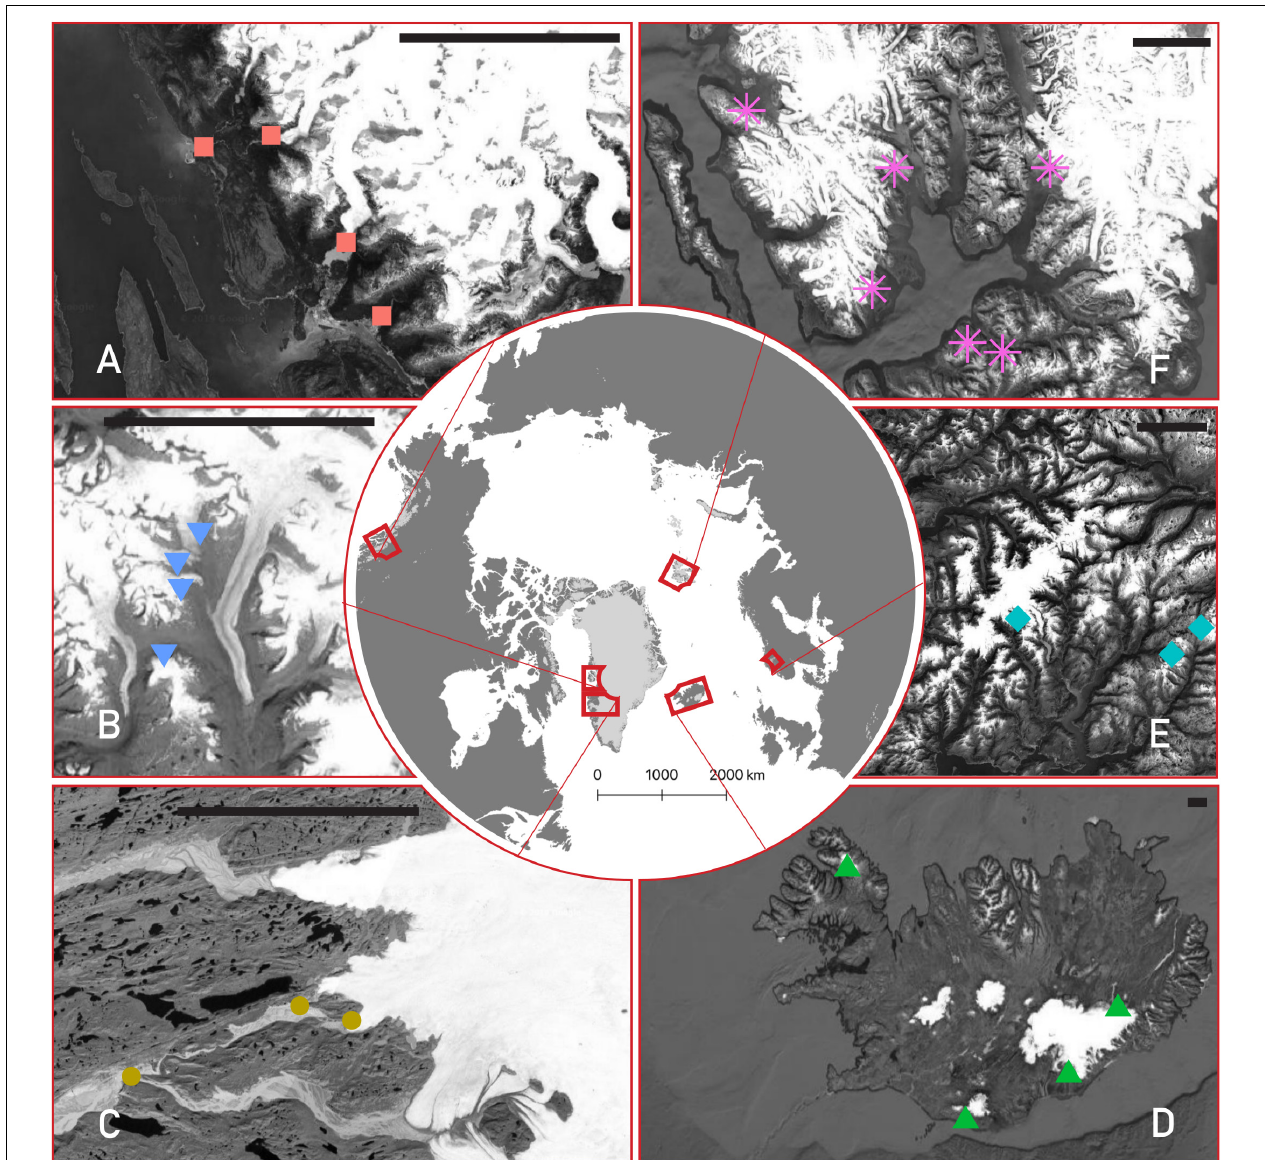
FIGURE 1 | Map of the six studied regions, with detailed insets for each showing the location of each glacier stream sampled. Counterclockwise from top-left: (A) southeast Alaska (red squares), (B) Qeqertarsuaq (Disko Island, blue upside-down triangles), (C) the Greenland Ice Sheet (gold circles), (D) Iceland (green triangles), (E) Norway (turquoise diamonds), and (F) Svalbard (purple asterisks). The scale bar in each panel represents 25 km. Background images are from Landsat/Copernicus and the United States Geological Survey, taken via Google and compiled with